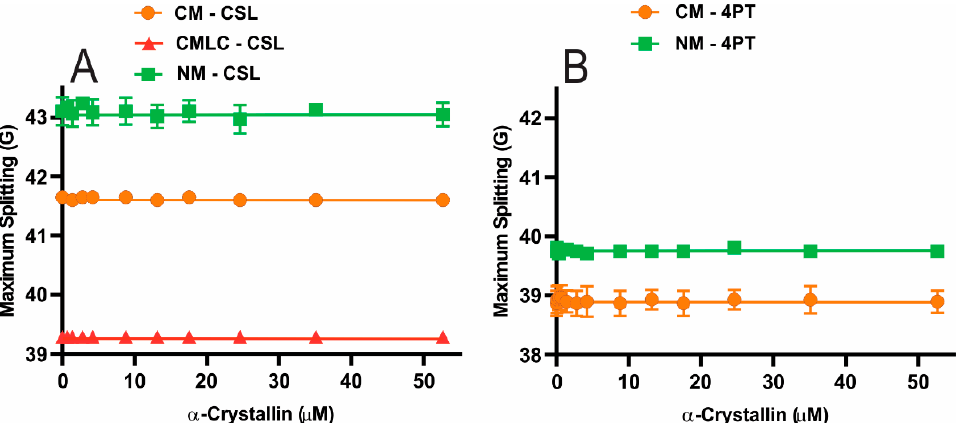
Figure 4. ( A ) The maximum splitting profiles obtained at 37 ◦ C using the CSL spin-labels within the bovine CM, the CMLC and the NM plotted as a function of α -crystallin concentration. ( B ) The maximum splitting profiles obtained at 37 ◦ C using the 4PT spin-labels within the bovine CM and NM derived from the total lipids extracted from a single lens plotted as a function of α -crystallin concentration. The smaller maximum splitting of the CM than the NM for the CSL and 4PT spin-labels implies that the CM below and on the surface is less ordered than the NM. With CSL spin-labels within the membranes, the maximum splitting of the CMLC is smaller than the CM. This implies that decreased Chol content within membranes decreases the order below the surface of membranes. Even with α -crystallin binding to the CM, the NM and the CMLC, the maximum splitting does not change significantly, implying that α -crystallin binding to these membranes does not significantly change the order below and on the surface. Results are the mean ± standard deviation ( σ ) from at least three independent